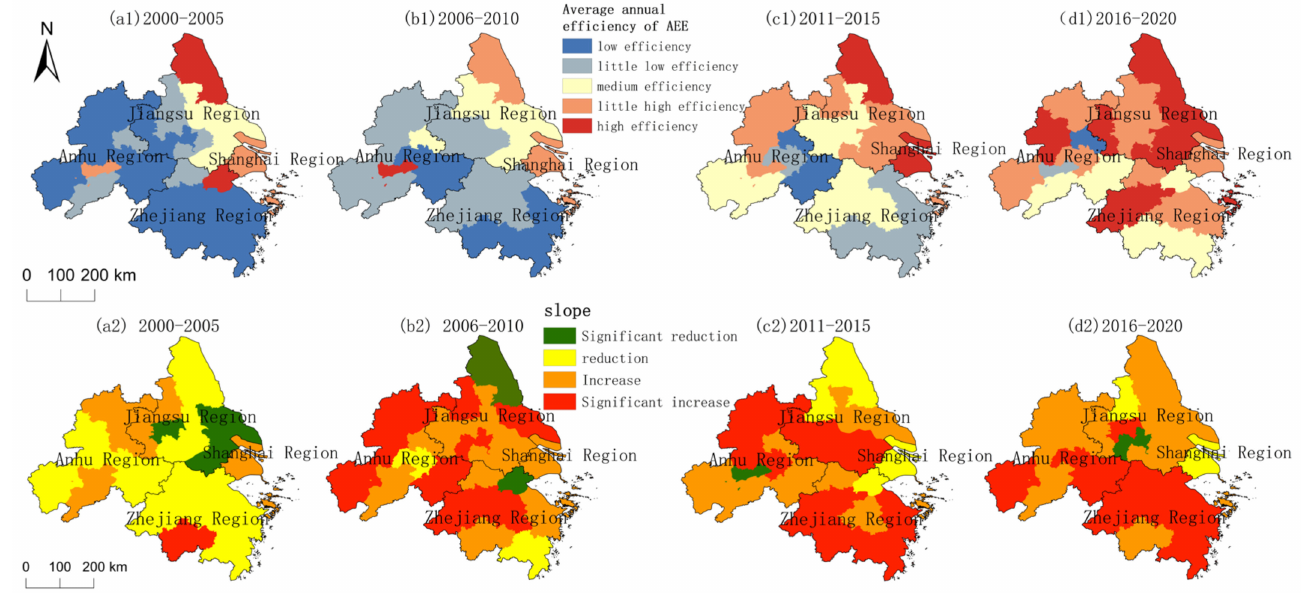
Figure 3. Spatial distribution of annual average AEE and slope changes in the YRD at four time